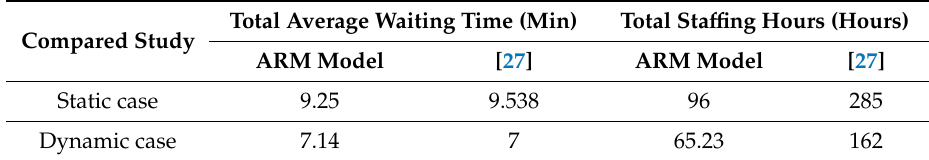
Table 3. Comparison with ARM results from Kierzkowski and Kisiel [27].